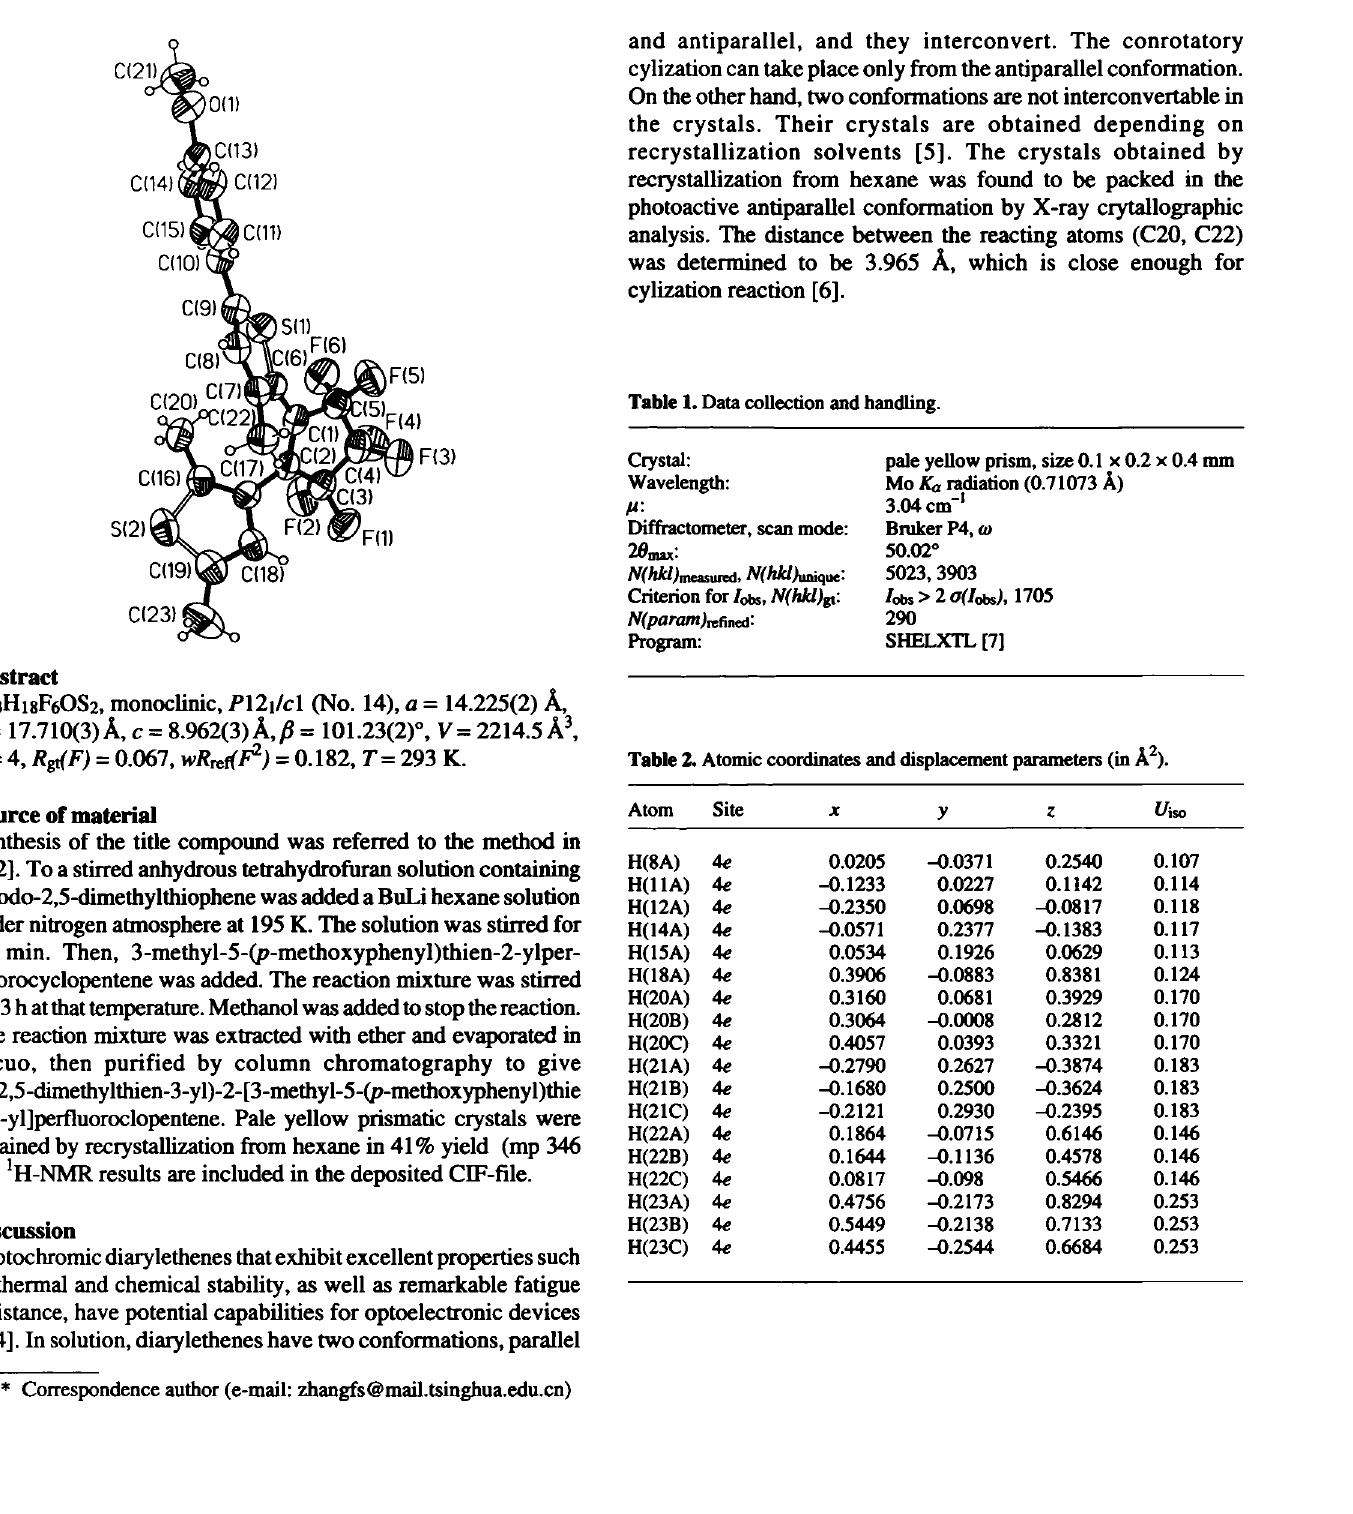
Table 1. Data collection and handling.